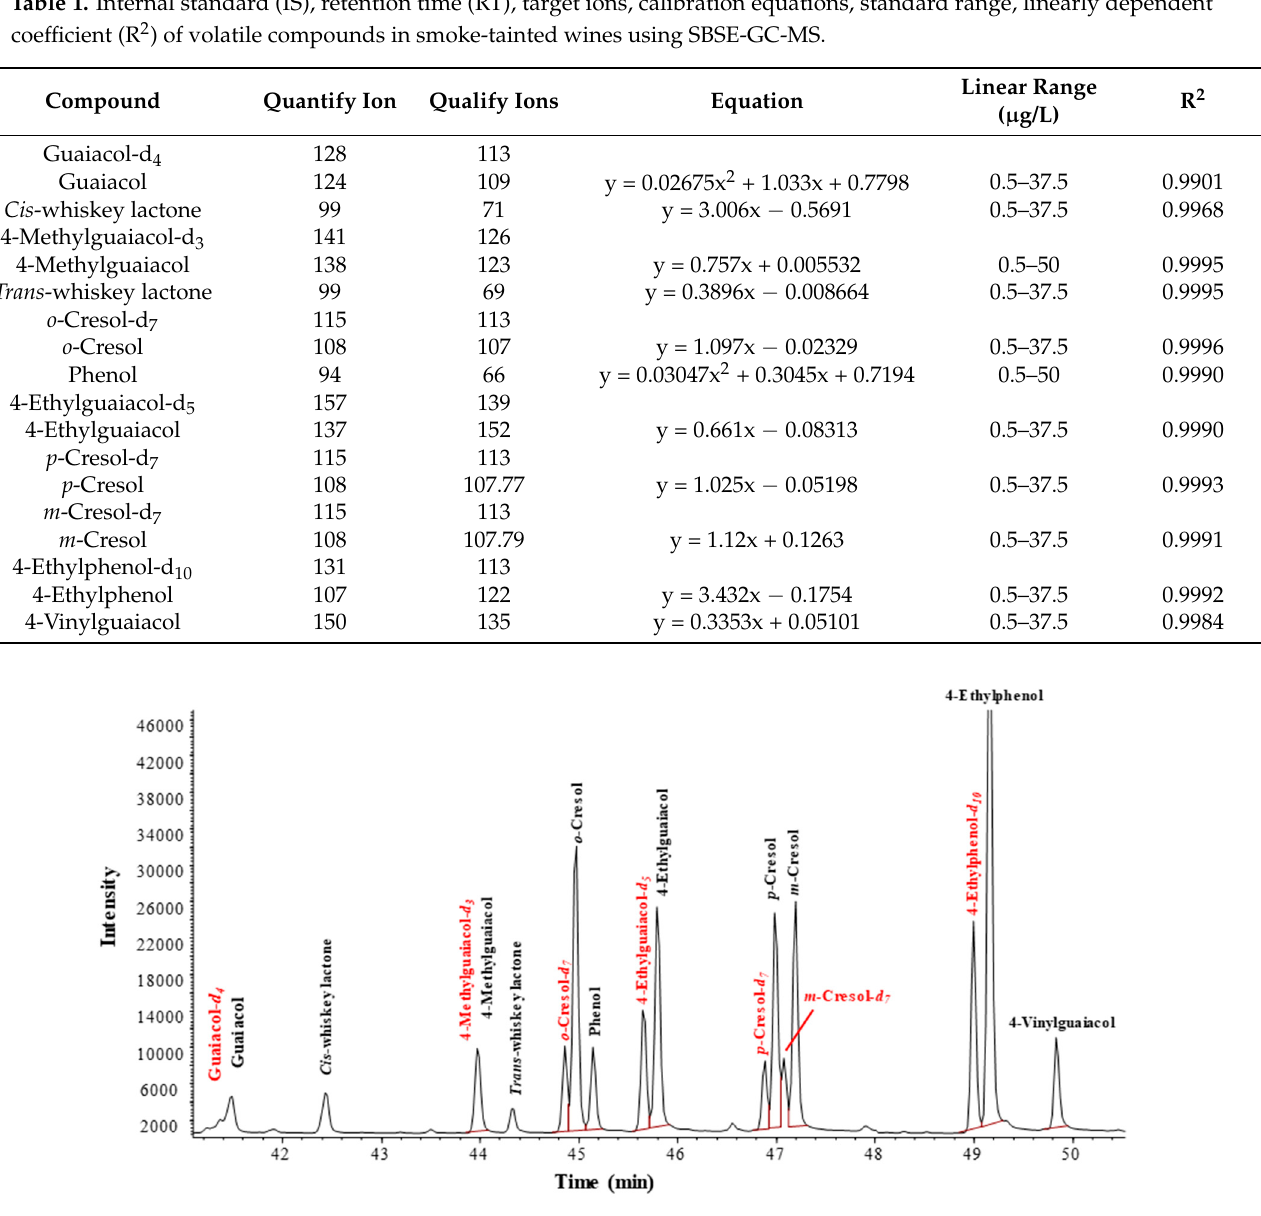
Figure 1. Chromatogram of eleven targeted compounds and internal standards under the chromatographic condition.